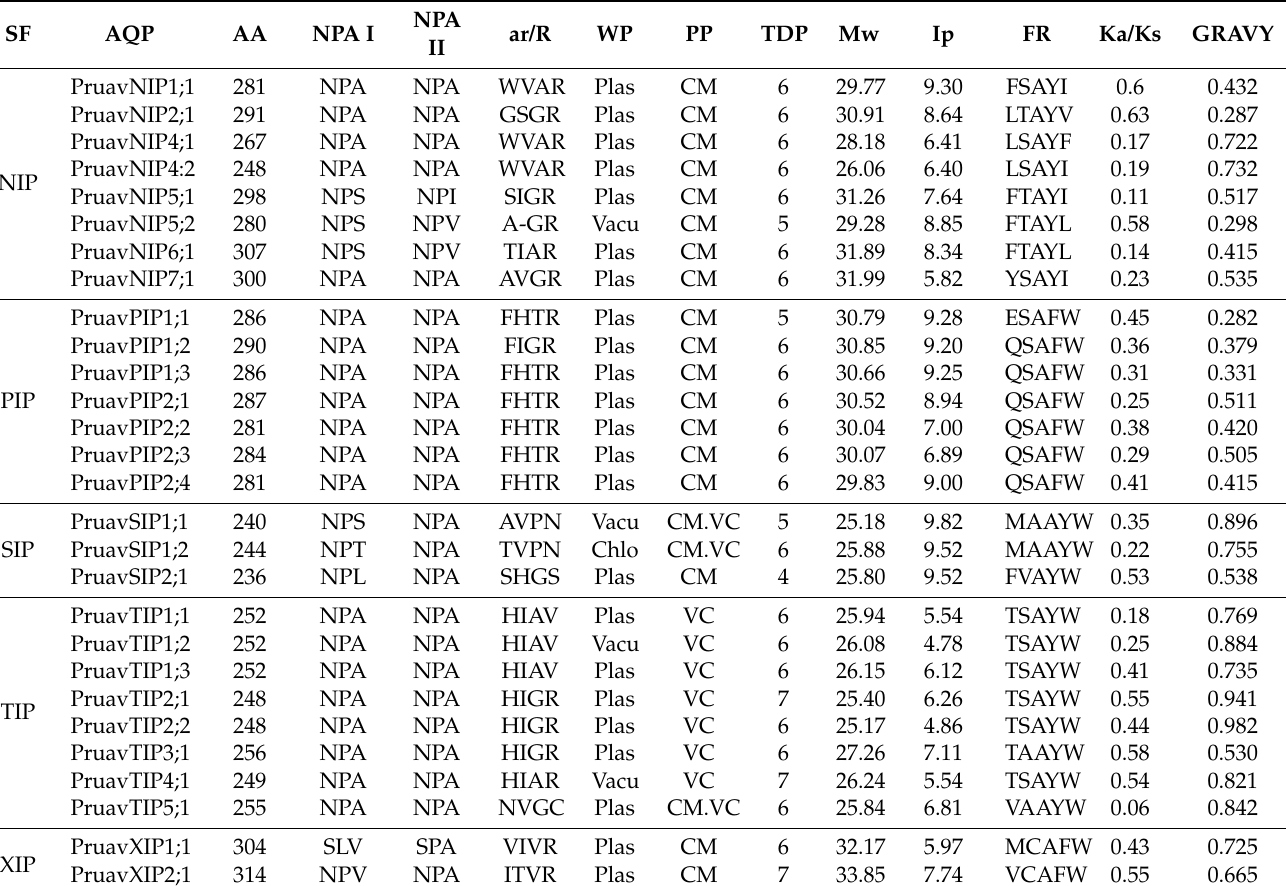
Table 1. Structural and subcellular localization analysis of P. avium aquaporins. SF: